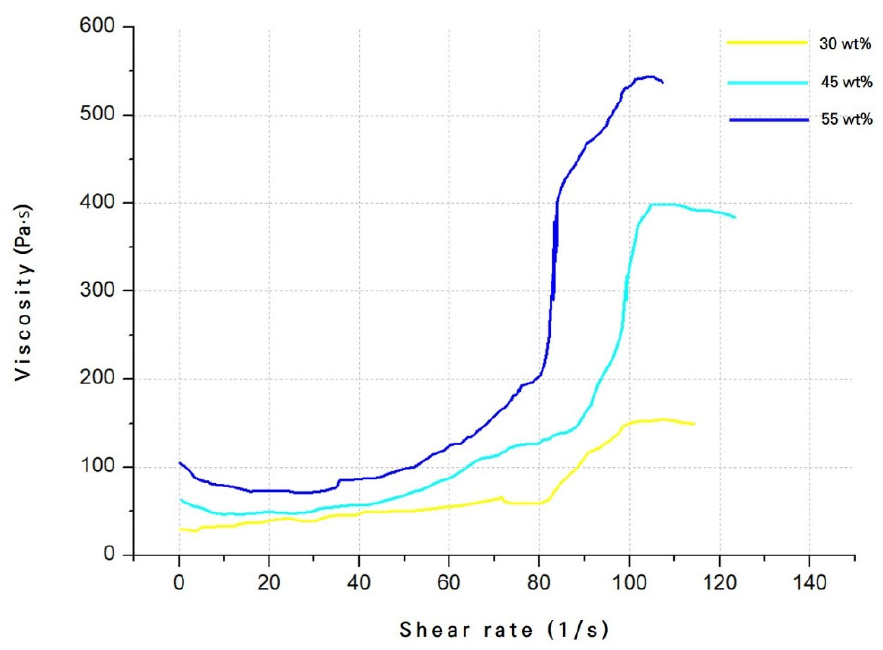
Figure 3. Results of the shear thickening fluid based stemming material’s rheological tests. The STF-based stemming material image and package products are shown in Figure